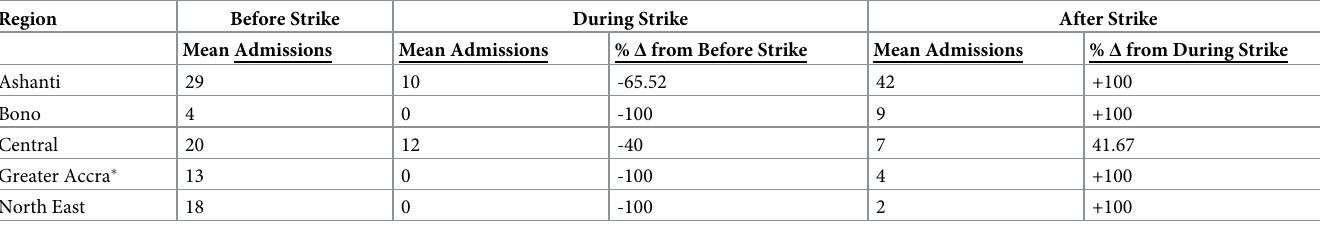
Table 9. Percentage change in mean admissions during and after strike. Region Before Strike During Strike After